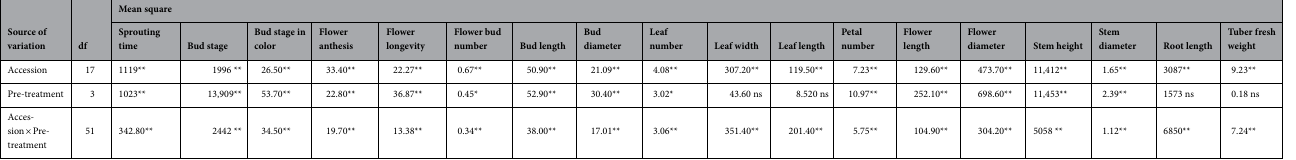
Table 1. Analysis of variance (ANOVA) for measured morpho-phenological traits of 18 studied of Anemone accessions under different pre-treatment conditions. ns (Non-significant), *(Significant at 5% probability level) and **(Significant at 1% probability level). Pre-treatment conditions included non-chilling, chilling, 5-azaC and GA 3